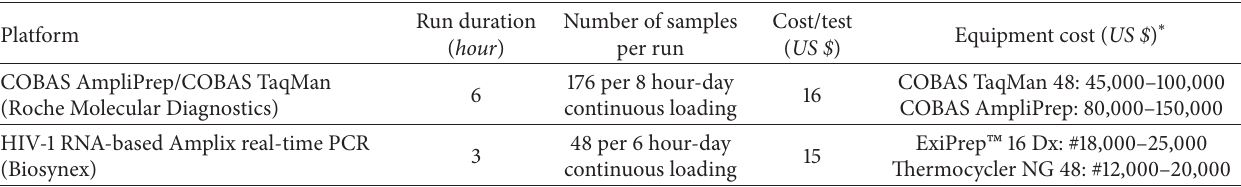
Table 6: Run duration (extraction plus amplification and lecture), number of samples per run, test cost and equipment cost for HIV-1 RNA- based Amplix real-time PCR assay, and the reference COBAS AmpliPrep/COBAS TaqMan HIV-1 test